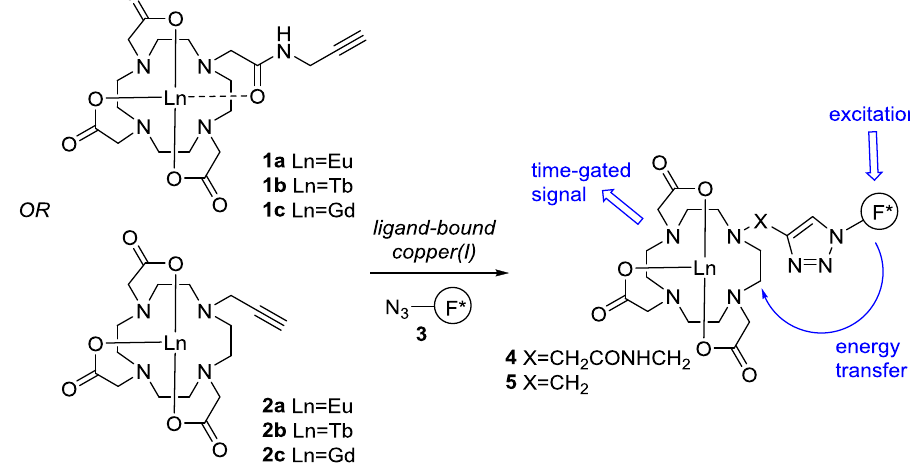
Figure 1. Sensor design for the detection of ligand-bound copper(I).